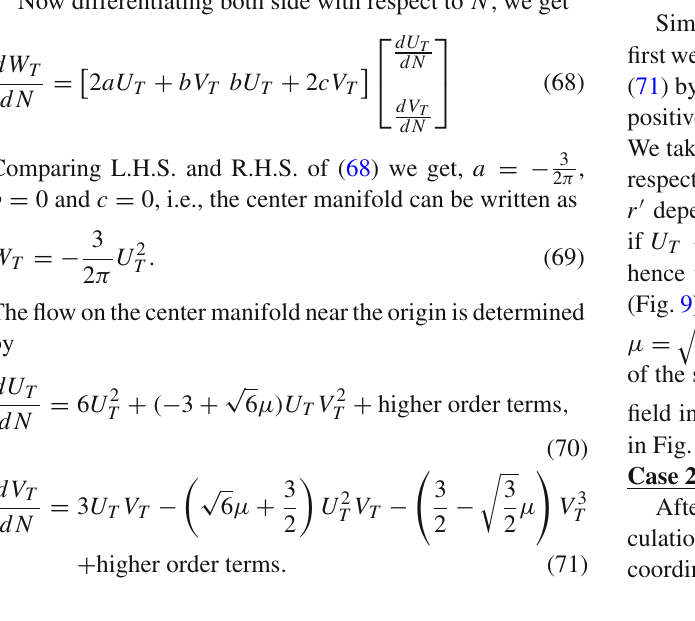
(cid:22) 3 is shown as 2